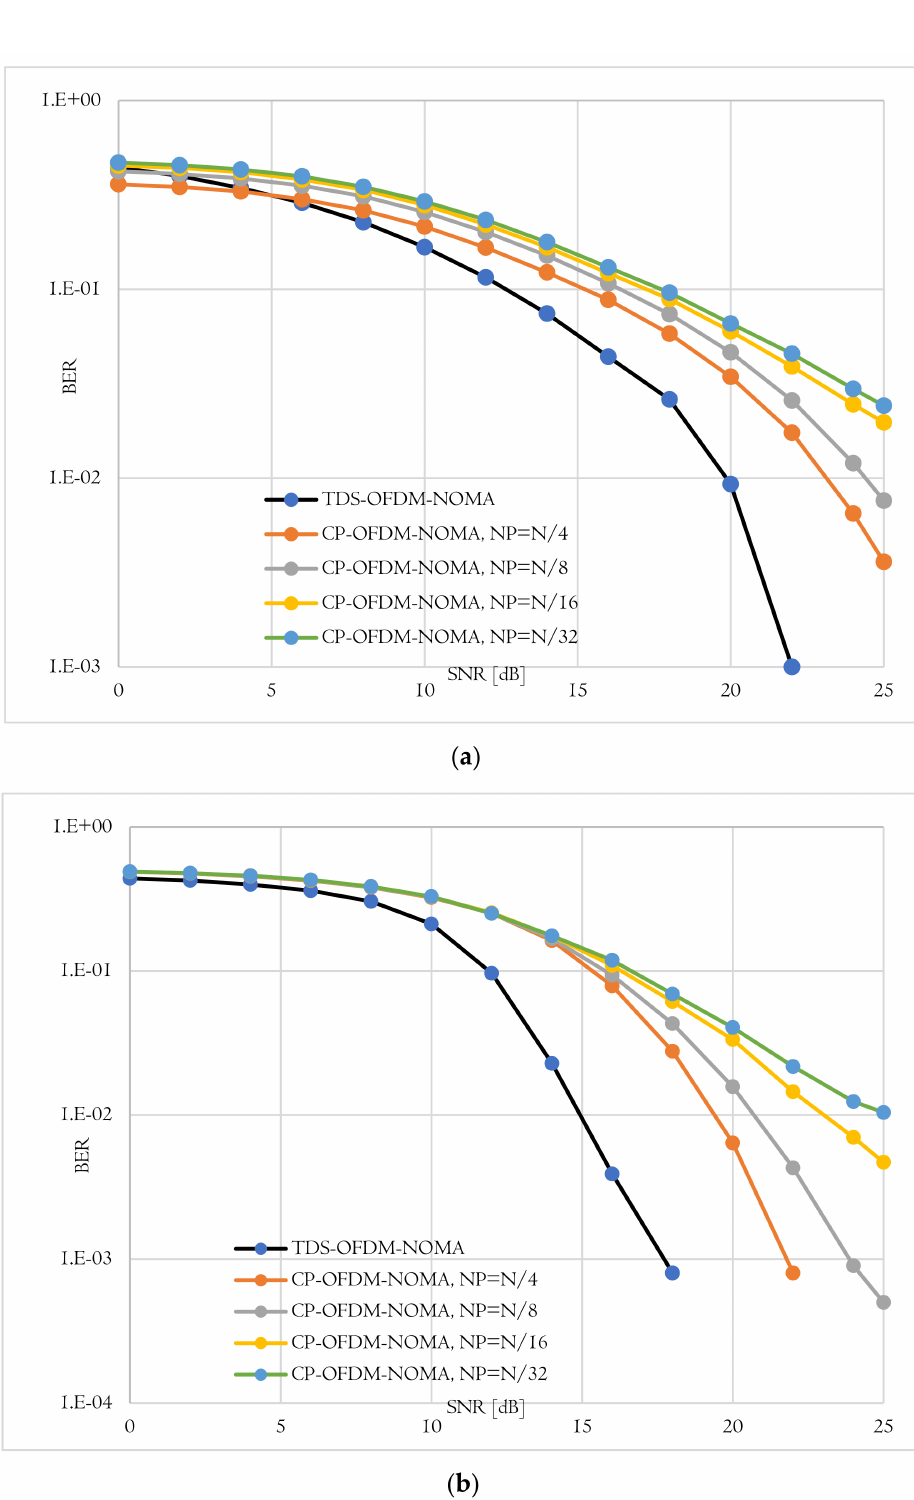
Figure 9. BER-(far-user) comparison of proposed TDS-OFDM-NOMA and convention CP-OFDM- NOMA; ( a ) Uncoded system and ( b ) Coded